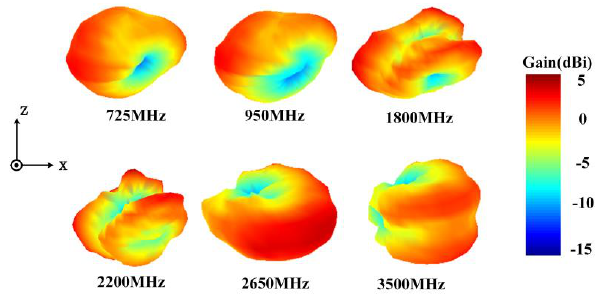
Figure 10. Measured 3D patterns of the proposed antenna.